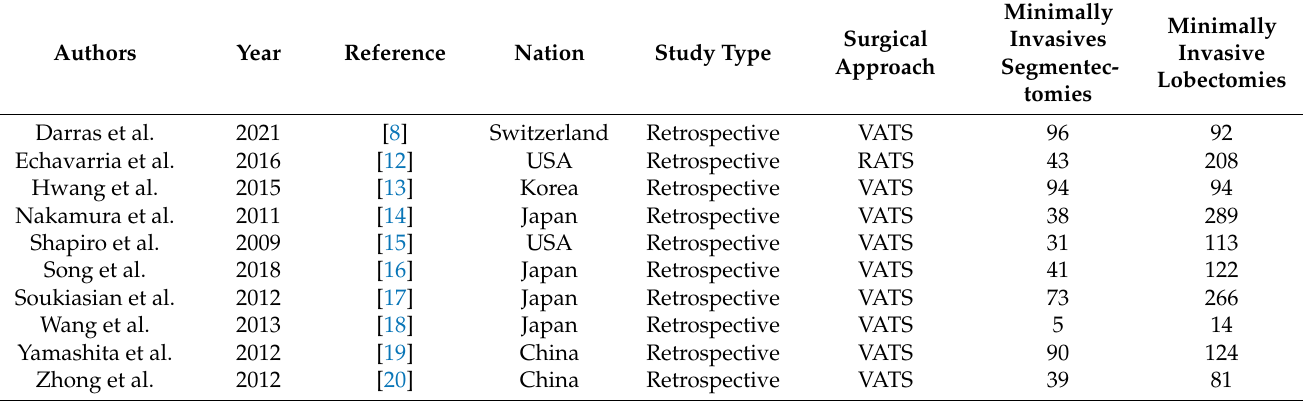
Table 1. A summary of the studies that comprised the systematic review and meta-analysis. RATS = Robot-Assisted Thoracic Surgery; VATS = Video-Assisted Thoracic